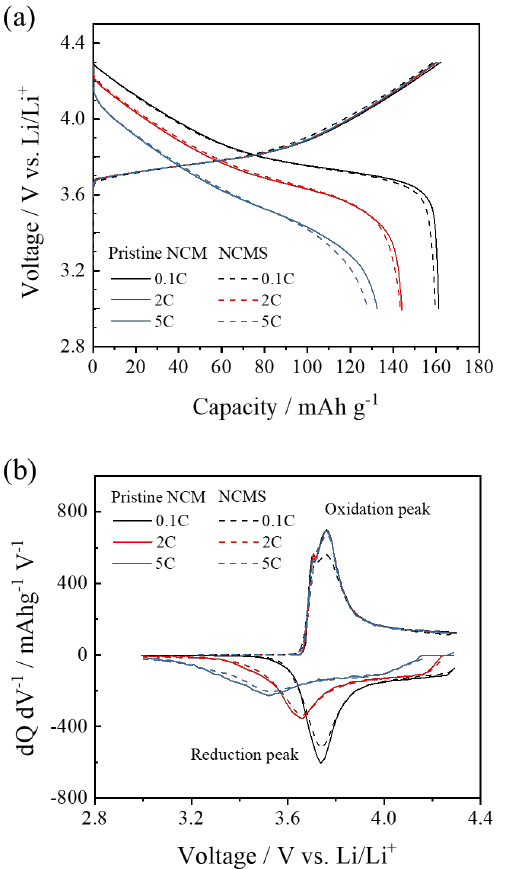
Figure 7. ( a ) Charge and discharge capacities and ( b ) dQ/dV plots of pristine NCM and NCMS at 0.1, 2, and 5